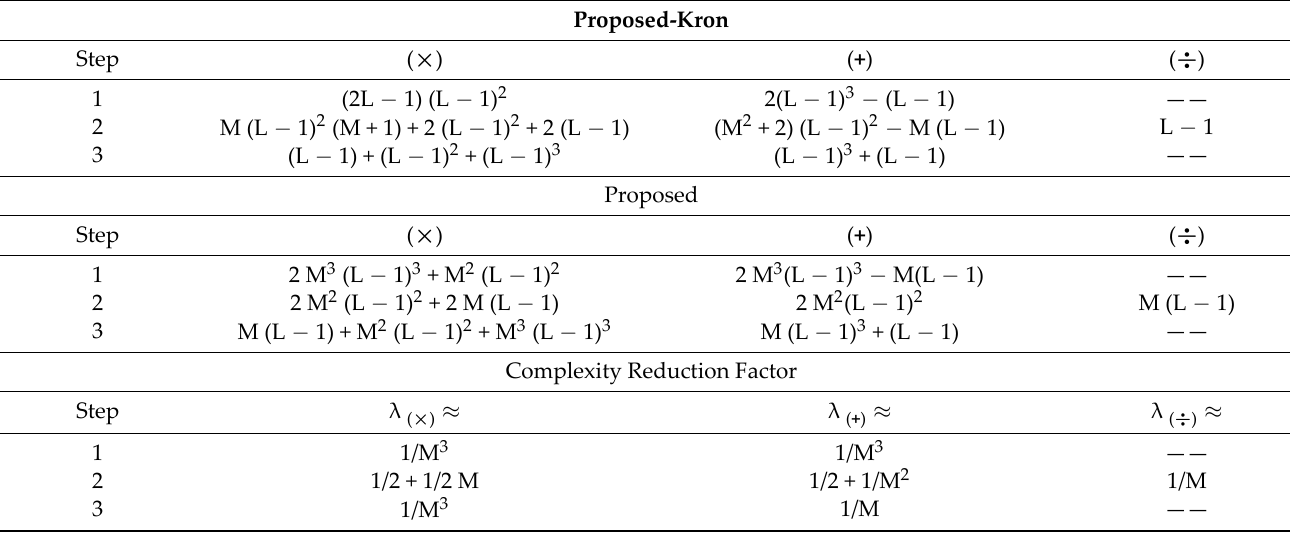
Table 5. Complexity